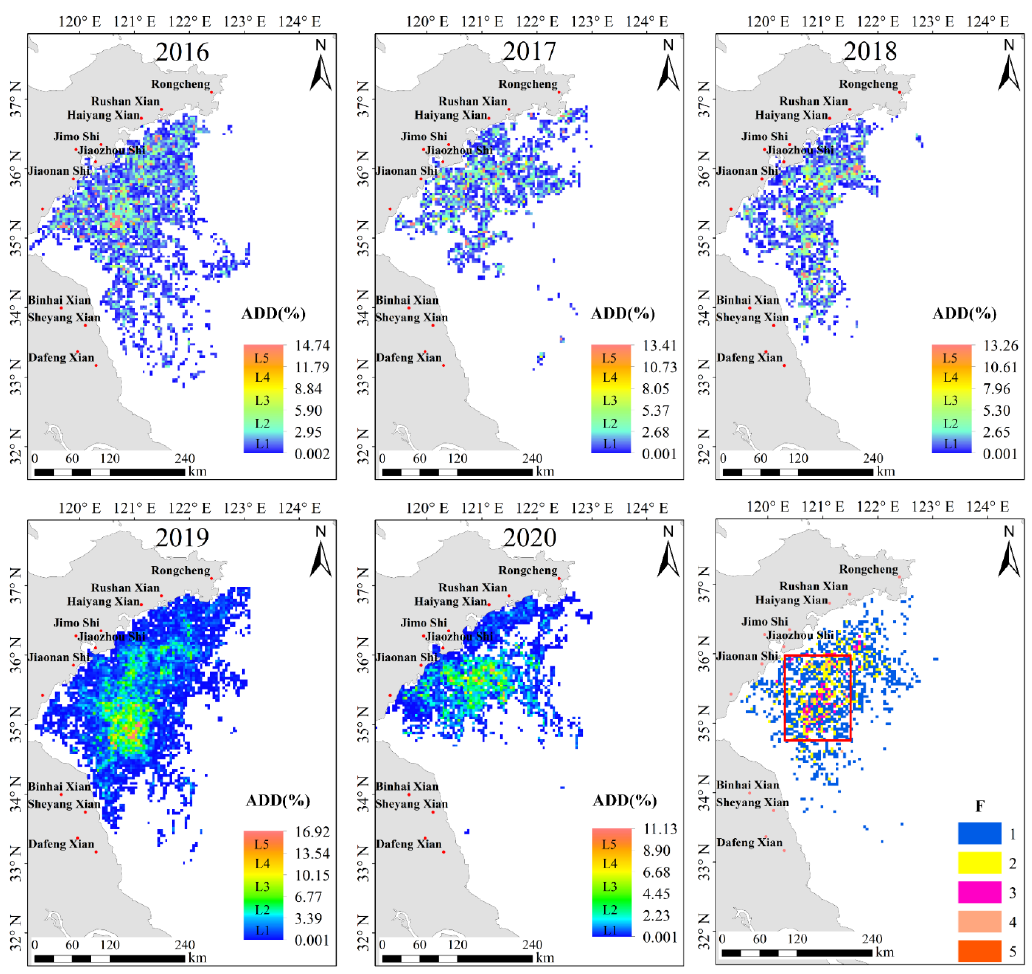
Figure 10. The annual distribution density of MABs (ADD) on the southern Yellow Sea from 2007 to 2020. The last figure is the coverage frequency of the seriously affected region (F) in these 14 years.